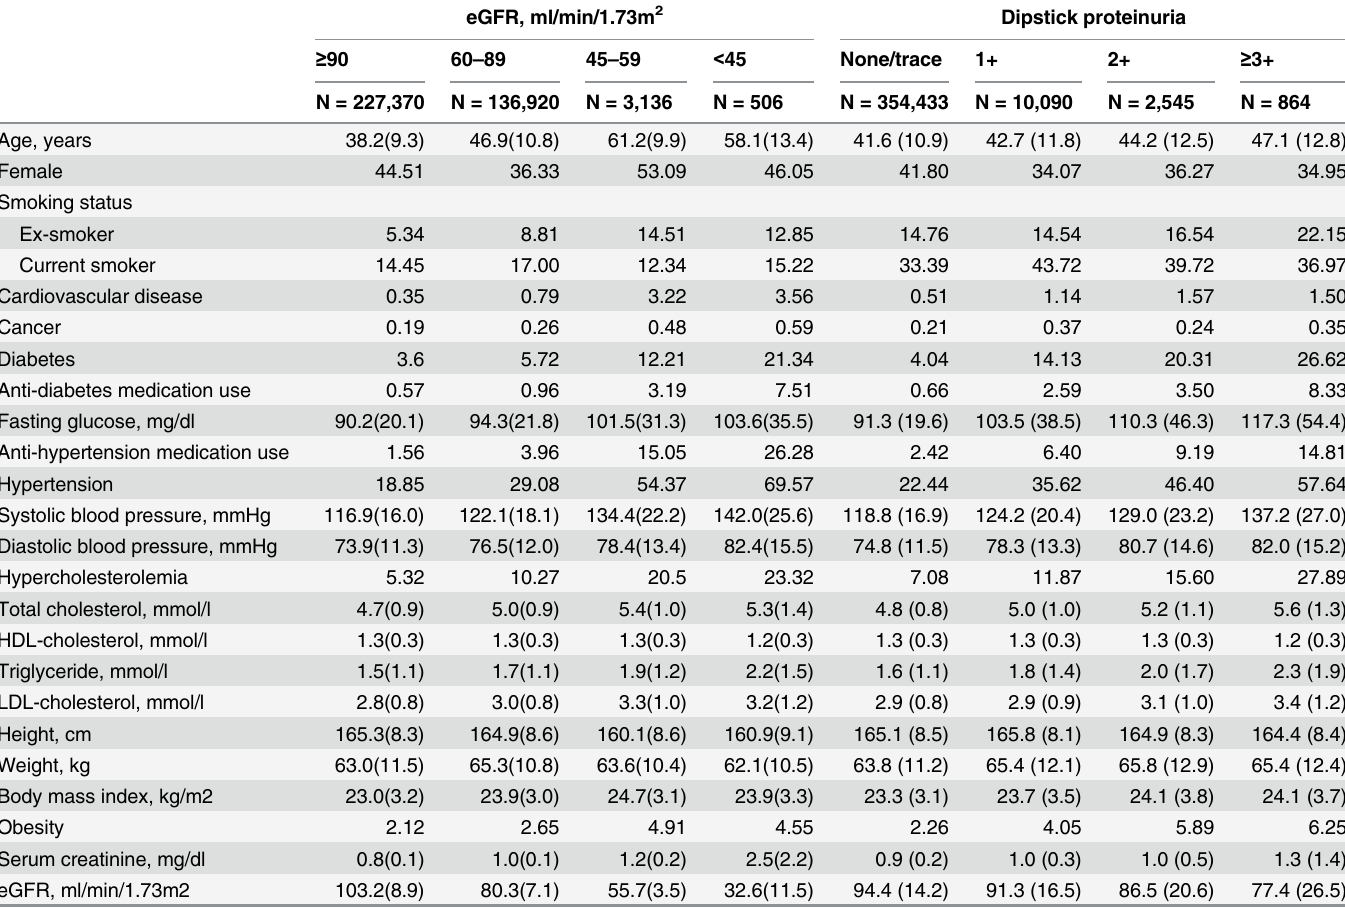
Table 1. Baseline characteristics by eGFR and dipstick in Korean Heart Study, N = 367,932. eGFR, ml/min/1.73m 2 ≥ 90